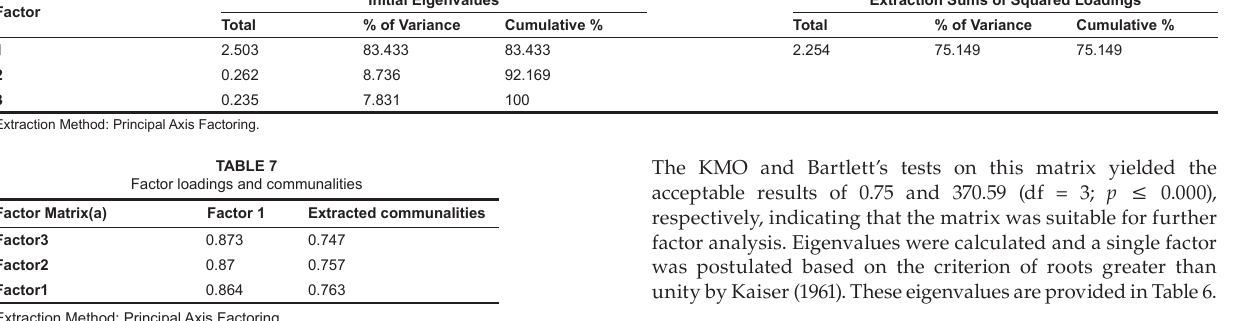
Item means and standard deviations for the overall scale and item reliability, the statistics are grouped according to scale sub-sections ( N = 178) Sub-section